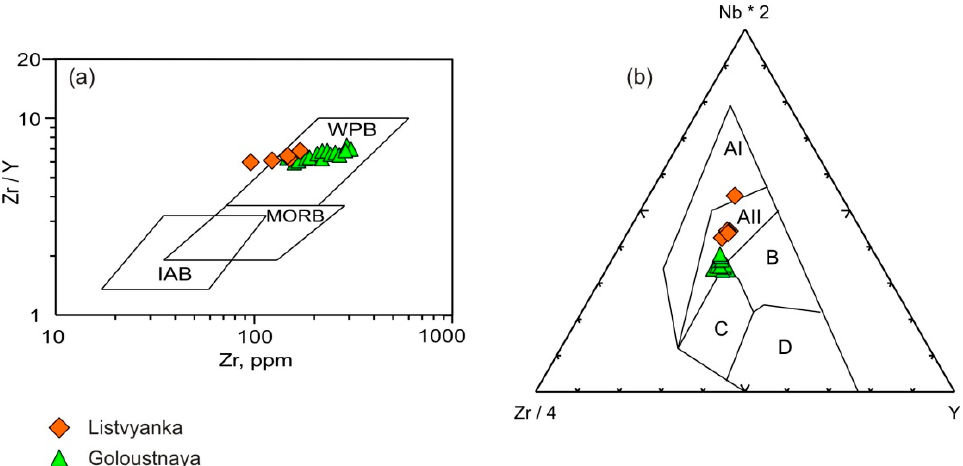
Figure 11. Th/Yb–Nb/Yb ( a ) and TiO 2 /Yb–Nb/Yb ( b ) diagrams [39] for Listvyanka and Goloustnaya dolerites. Abbreviations: N ‐ MORB, normal mid ‐ ocean ridge basalts; E ‐ MORB, enriched mid ‐ ocean ridge basalts; OIB, oceanic island basalts; Th, tholeiitic OIB; Alk, alkalic OIB.